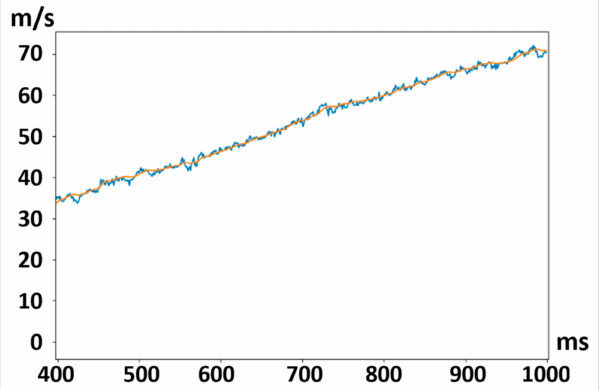
Figure 11. Output response with EKF of level 4.